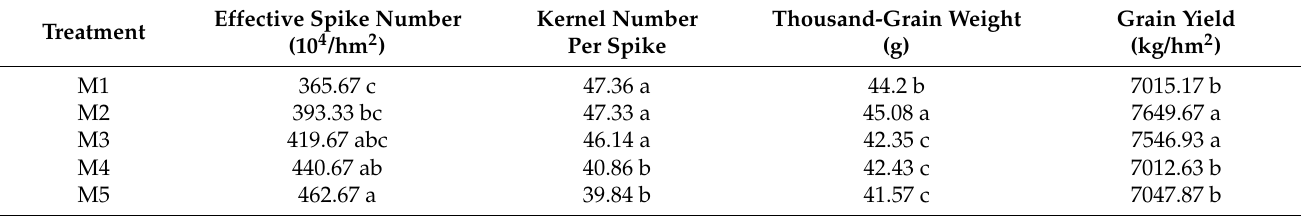
Table 3. Effects of plant density on yield and yield